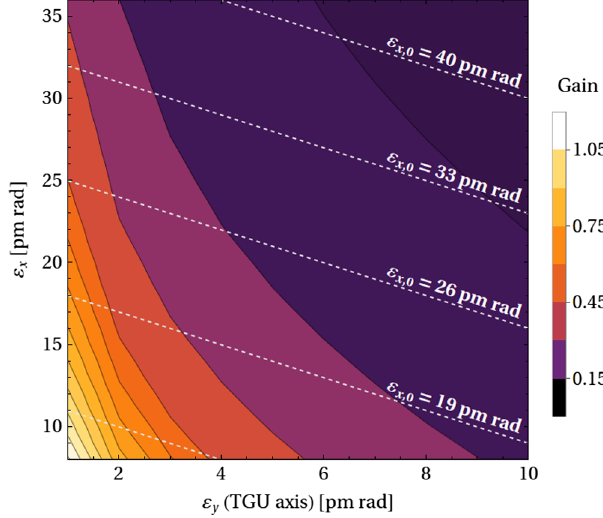
FIG. 5. Contour plot of gain as a function of transverse emittances ε , ε . White dashed lines represent levels of constant x y 6 . 2 cm and α ≡ ε ε opt ¼ opt ¼ natural emittance ε . For fixed ε , reducing the x; 0 x þ y x; 0 ≡ ε = ε emittance ratio k (hence reducing ε ) results in signifi- c y x y cant gain improvement. Hence it would be advantageous for the TGU to minimize k for given ε c x; 0